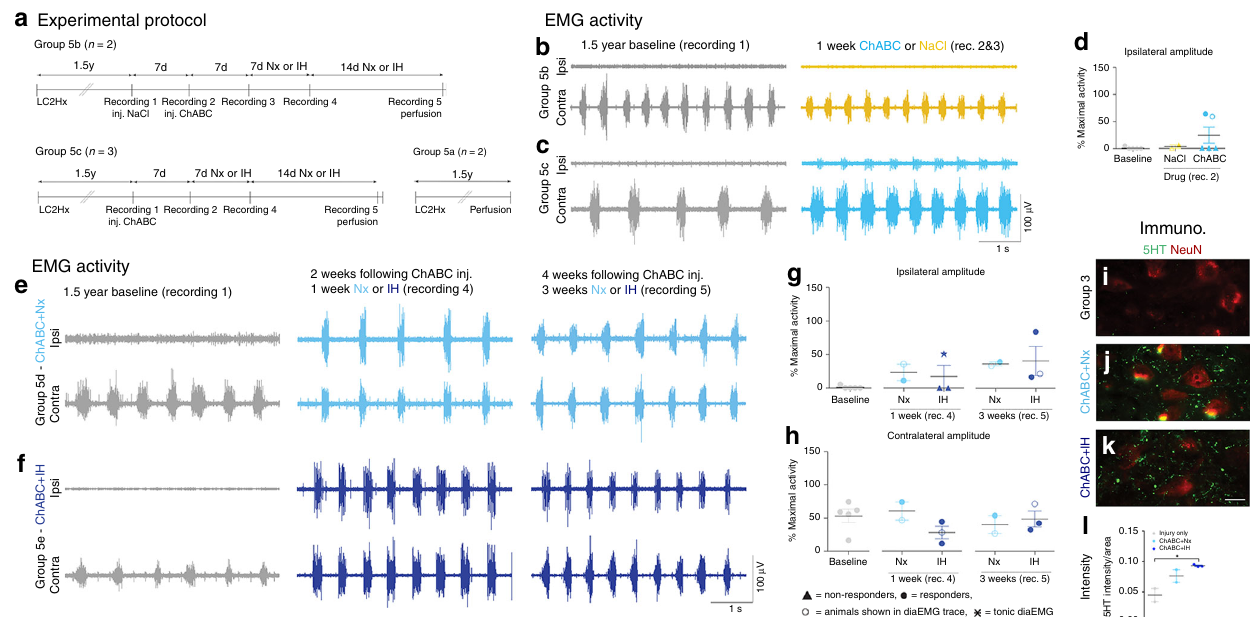
Fig. 6 PNN digestion recovers respiratory activity a year and a half after spinal injury. a Experimental protocol. b – d DiaEMG at baseline (grey; n = 5) and following either b NaCl (yellow; n = 2) or c ChABC (light blue; n = 3). d Average amplitude of ipsilateral diaEMG. e – h DiaEMG at baseline (grey; n = 5) and following ChABC and e air (light blue; n = 2) or f IH (blue; n = 3). g , h Average amplitude of g ipsilateral and h contralateral diaEMG. i – l Immunohistochemistry and intensity readings at the ipsilateral C4 PMP utilizing NeuN and 5HT for i injury only, ChABC and j air or k IH. Scale bar = 50 μ m ( n = 2/3 per group). For all EMG or graph panels, treatment groups = baseline (grey); saline + air (yellow); ChABC + air (light blue); ChABC + IH (blue). For d , g , h : fi lled circles = responders; un fi lled circles = animals in b , c , e , f ; triangles = non-responders; stars = tonic activity shown. If no post-hoc result is shown, comparison was not-signi fi cant. For all panels: values represent mean ±